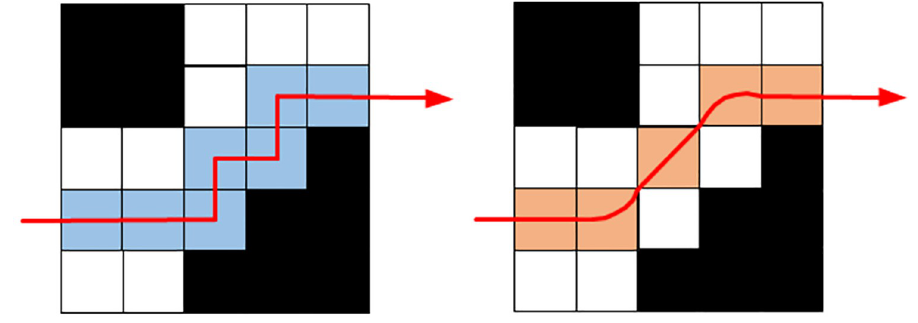
Fig 5. Smoothing optimization strategy for continuous right-angle